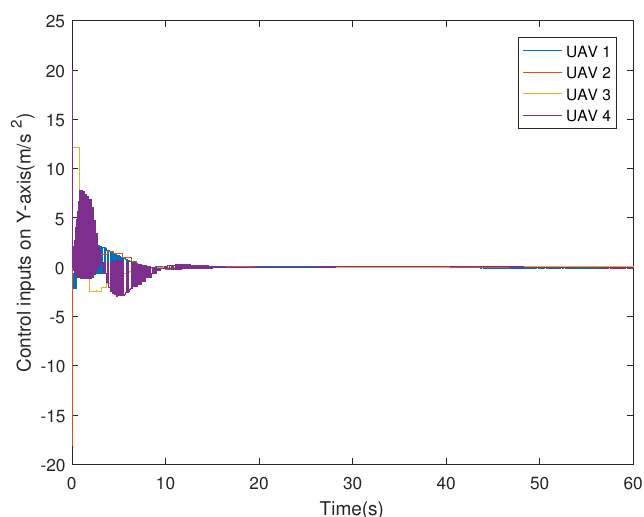
Figure 10. Control inputs of the four UAVs on X-axis.